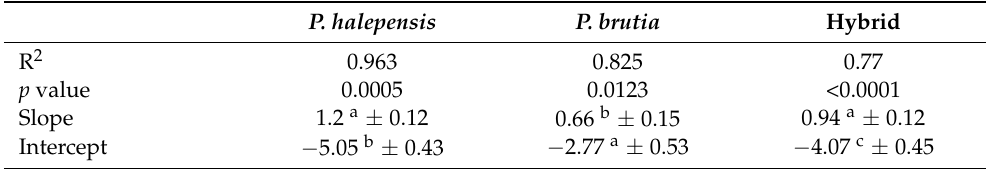
Table 2. One-way ANOVA of the effect of P. halepensis , P. brutia , and their hybrids on the log- transformed values of Ψ PD vs. SWC and their slopes and intercepts ± standard error. Different superscript letters indicate significant differences between the genotypes ( p <